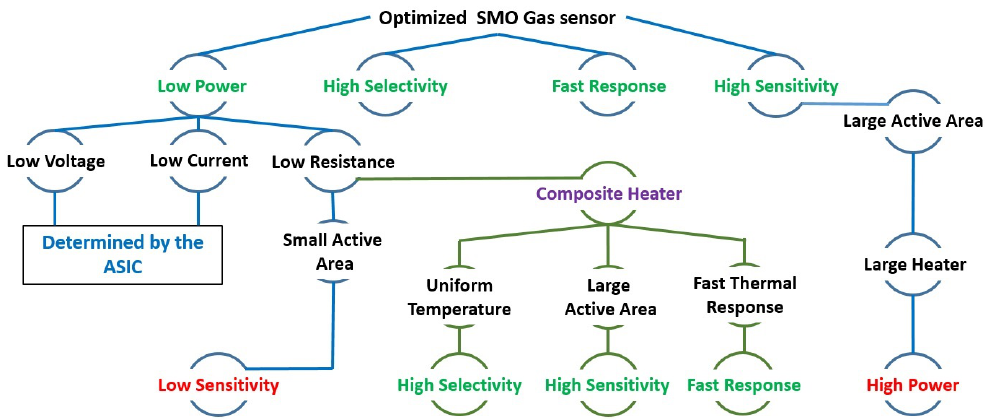
Figure 1. Limitations and required elements to enhance the sensing capability and performance of SMO gas